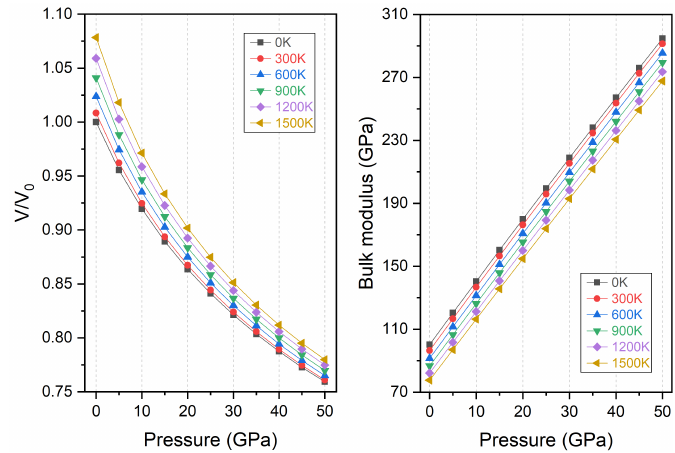
Figure 11. The normalized volume (V/V 0 ) and bulk modulus variation with pressure for Ti 2 MnAl